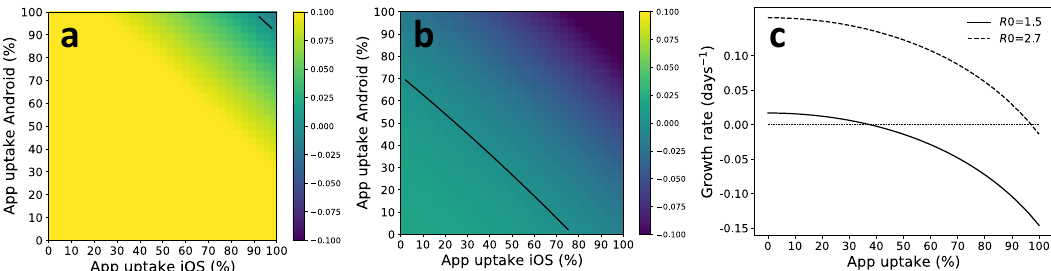
Fig. 4 The impact of app uptake on the spread of SARS-CoV-2. The plots show the estimated growth rate r as a function of app uptake among Android and iOS users. We have assumed 90% ef fi cacy of case isolation and a 4 h delay of both case isolation and contact quarantining. a Shows the situation for R0 = 2.7 and b shows R0 = 1.5. c Shows the same data, but assuming identical app uptake among iOS and Android users. Note that R0 denotes the initial reproduction number of the pandemic, which is the expected number of new cases that are caused by an infected ef fi cacy as a function of app uptake was computed from (1), as user groups. In Fig. 4a, we chose the initial reproduction number as R0 = 2.7, which is in line with reported numbers from the early model of Ferretti et al 3 , which describes the effect of contact phase of epidemic spread in various countries 28,29 . Figure 4b tracing on pandemic spread. Figure 4a, b shows the estimated shows the growth rate for R0 = 1.5, chosen to represent a more growth rate r (in days − 1 ), as a function of app uptake in the two slowly growing epidemic resulting from control measures such as